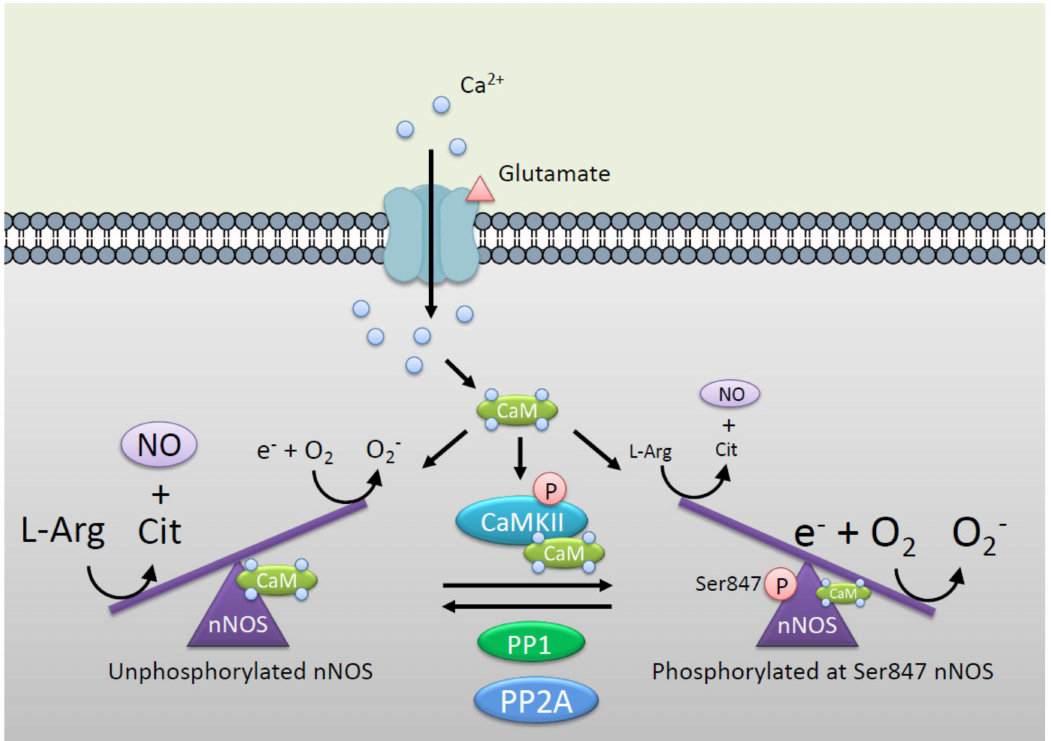
Figure 2. nNOS catalytic reaction is controlled by CaMKII via phosphorylation at Ser847. Unphosphorylated nNOS produces NO by conversion from L-arginine to L-citrulline via electron transfer from reductase domain to oxidase domain. Phosphorylation at Ser847 by CaMKII switches nNOS reaction from NO synthesis to superoxide (O 2 − ) synthesis via induction of uncoupling of nNOS [28]. Protein phosphatase 2A (PP2A) [45,47,48] and PP1 [49] are identified as major protein phosphatases involved in the dephosphorylation of nNOS at Ser847, responsible for reversible activation of the enzyme in neuronal cells. This figure is an image of the postsynaptic hippocampal neuron where the mutual regulation of nNOS and CaMKII mainly